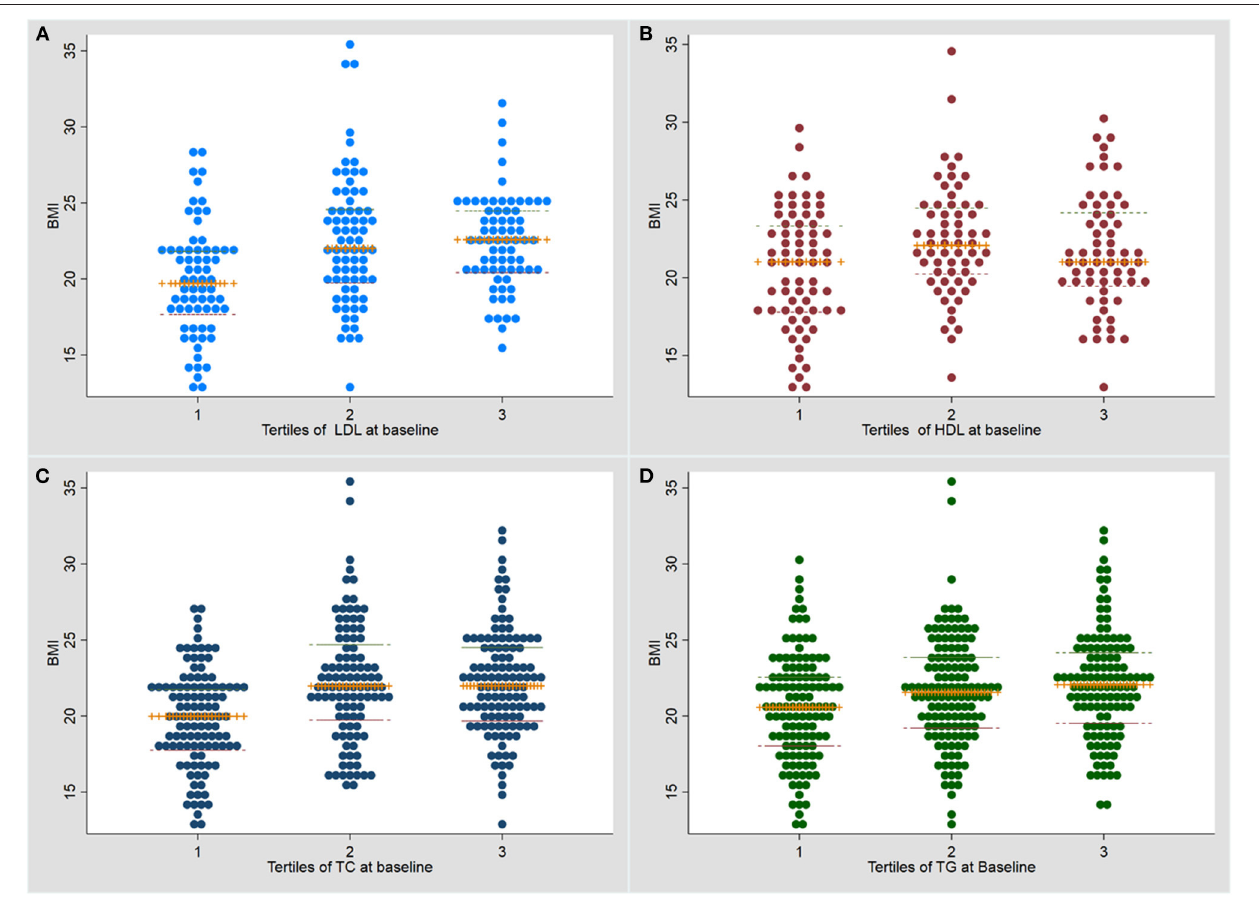
FIGURE 1 | Dot plot for the association of baseline serum lipid levels with body mass index at baseline. (A) LDL (low density lipoprotein); (B) HDL (high density lipoprotein); (C) TC (total cholesterol); (D) Triglycerides (TG). TB, tuberculosis; BMI, body mass index.